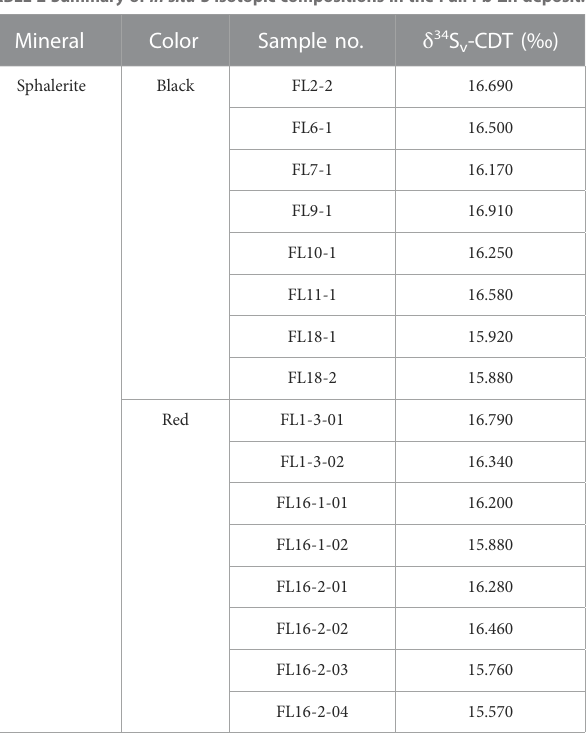
TABLE 2 Summary of in situ S isotopic compositions in the Fuli Pb-Zn